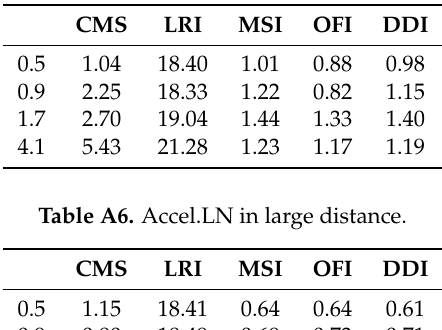
Table A5. Accel.XS in large distance.